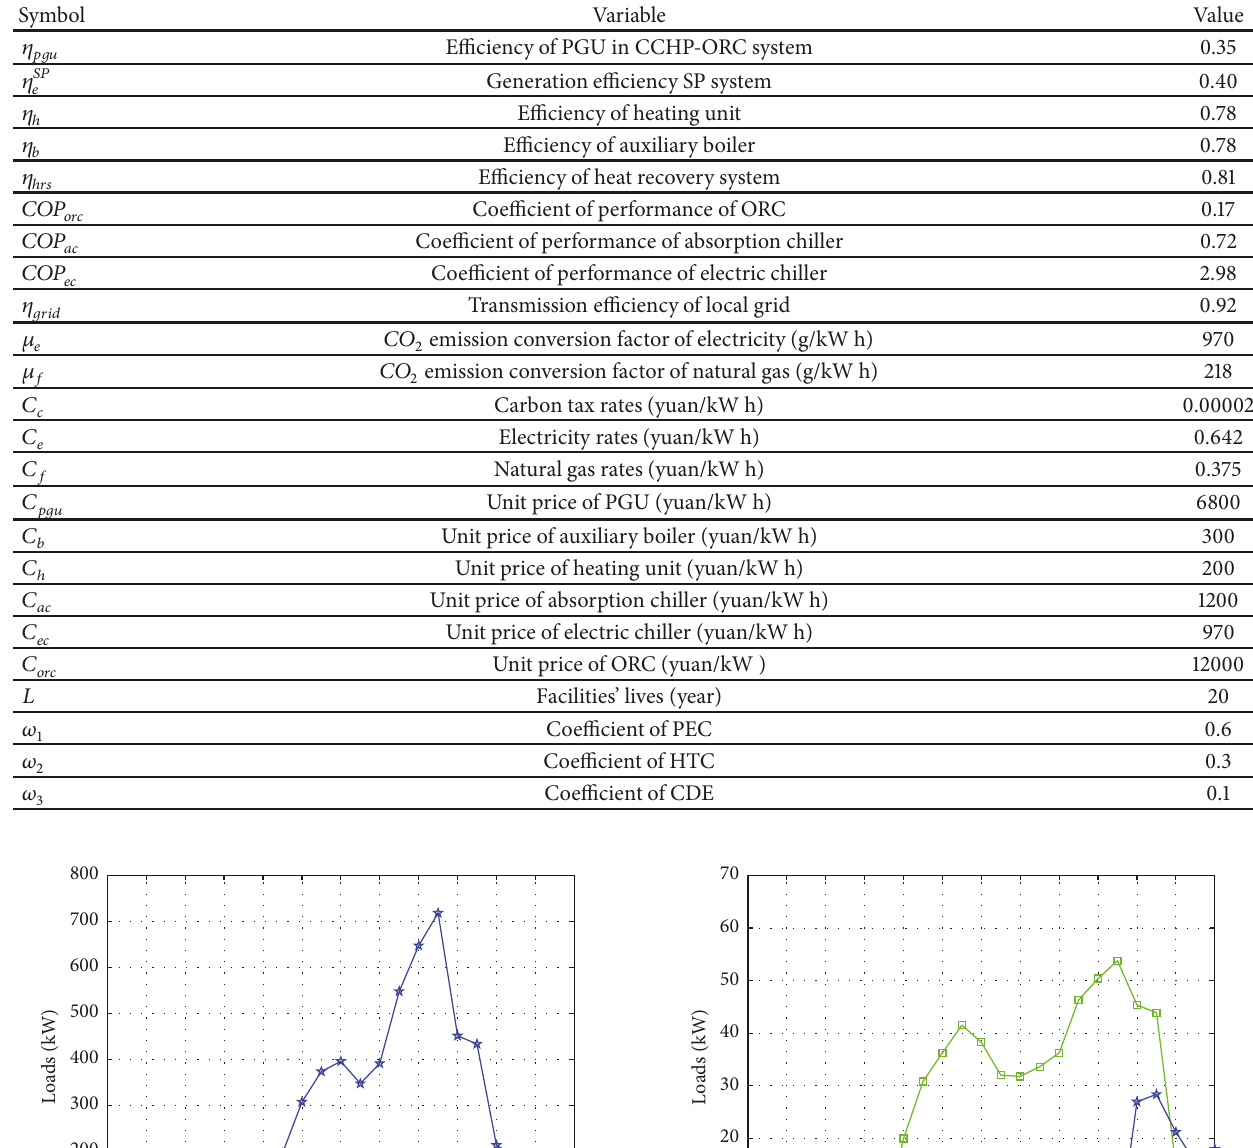
Table 2: System coefficients.